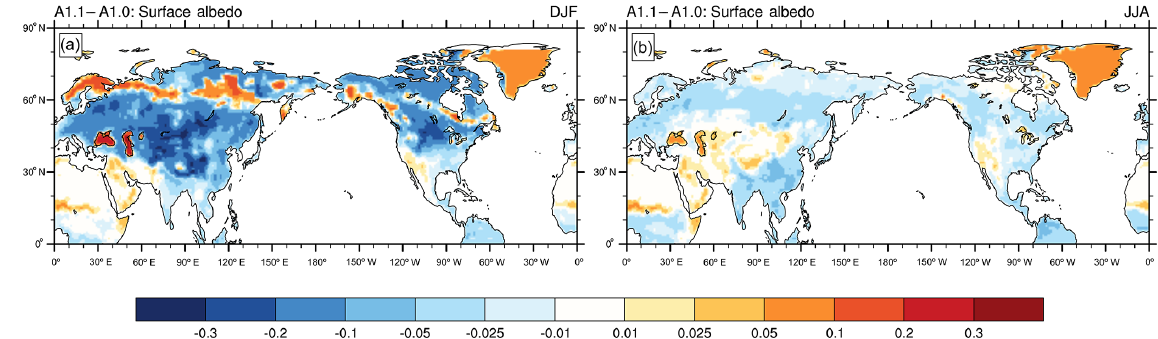
Figure 5. Seasonal mean surface albedo difference between ACCESS1.1 and ACCESS1.0 for (a) DJF and (b) JJA.